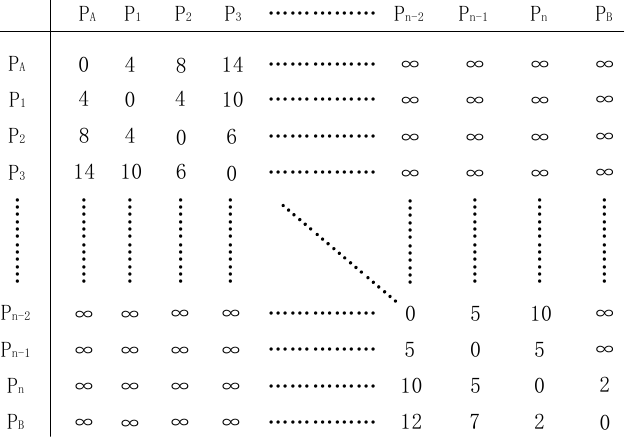
Figure 10. Topology matrix of prefabricated component hoisting route planning. Table 1. Effect analysis table of hoisting route planning for a prefabricated floor. Prefabricated Floor Hoisting Hoisting Situation